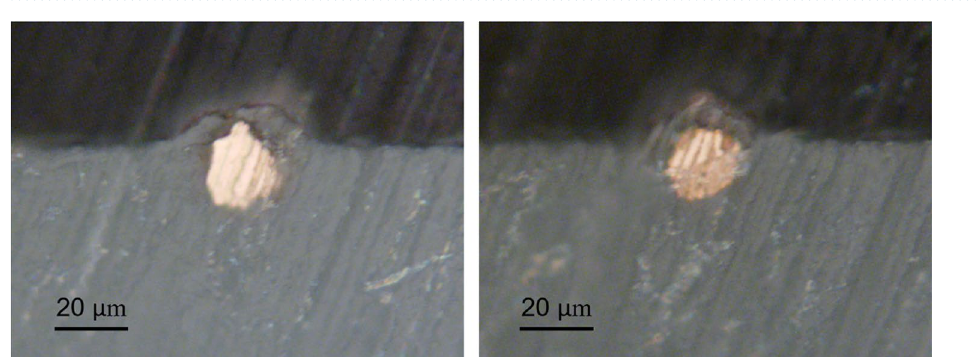
Figure 5. OM images showing the cross-section of two representative interlocked